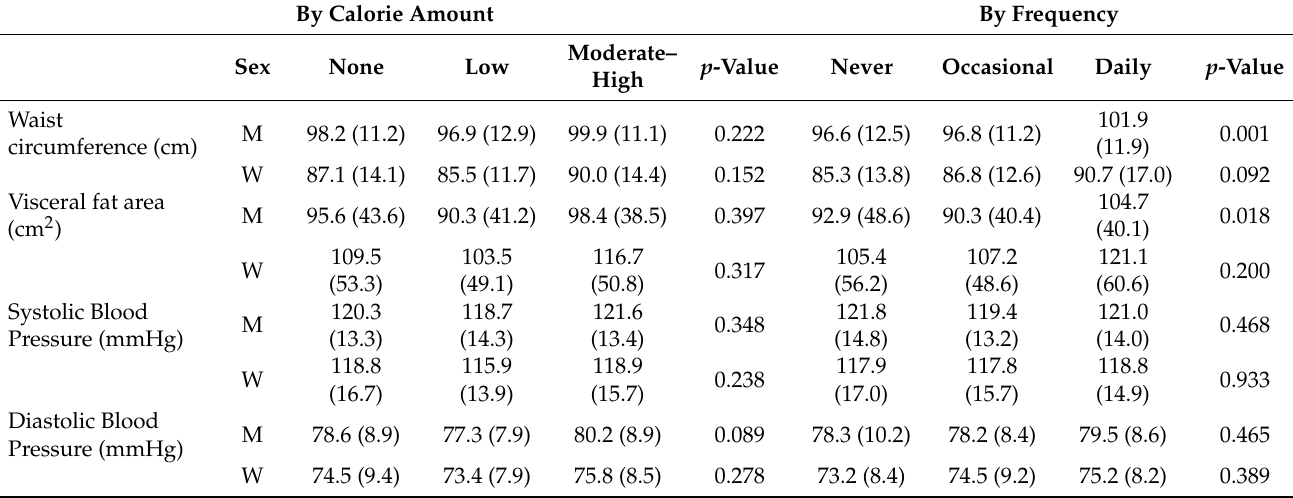
Table 3. Description of the values of cardiometabolic biomarkers by SSBs consumption patterns (by calorie amount and by frequency) stratified by